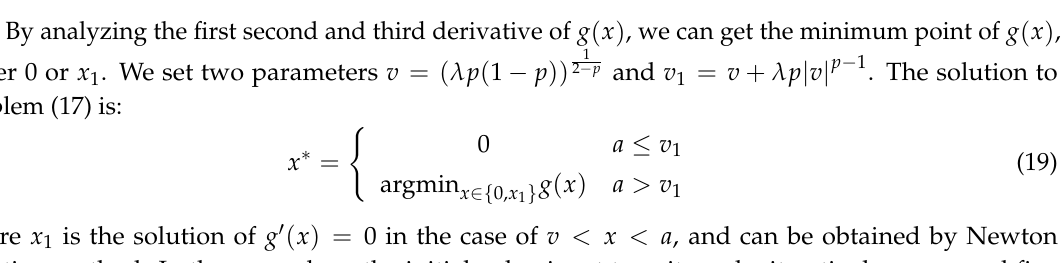
Figure 3. Illustration of the